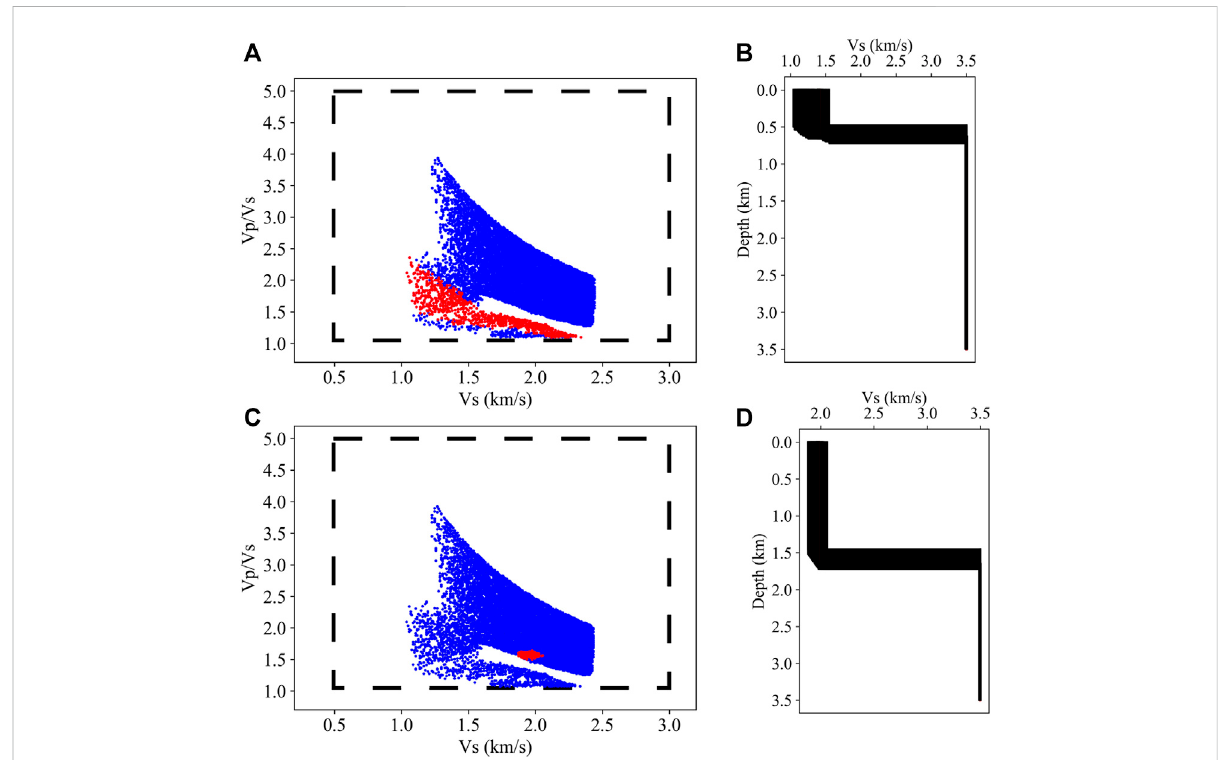
FIGURE 11 TheinversionresultswiththesubsetdataoftheSP15seismicdata.Atotalof10 6 two-layermodelswererandomlygeneratedinthemodelspace outlinedbytheblackdashedboxin (A) and (C) .Thebluedotsin (A) and (C) arethemodelsacceptedbymultimodaldispersioncurves.Thereddotsin (A) are the models accepted by the multimodal dispersion curves and the Sg traveltimes, and the red dots in (C) are the models accepted by the multimodal dispersion curves and Pg traveltimes. (B) and (D) present accepted models (the red dots in (a) and (C) ) with the Vs-depth relation. The contradictory results accepted by different subset data demonstrate that it is important to use both the surface waves and the P-and S-body waves to constrain the subsurface